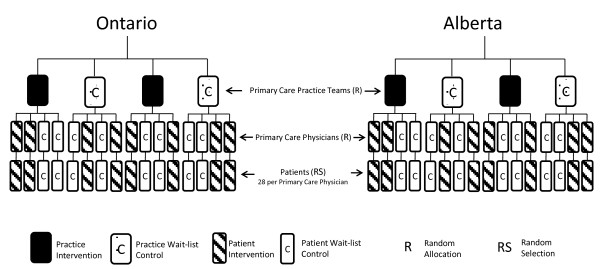
Trial design schema.